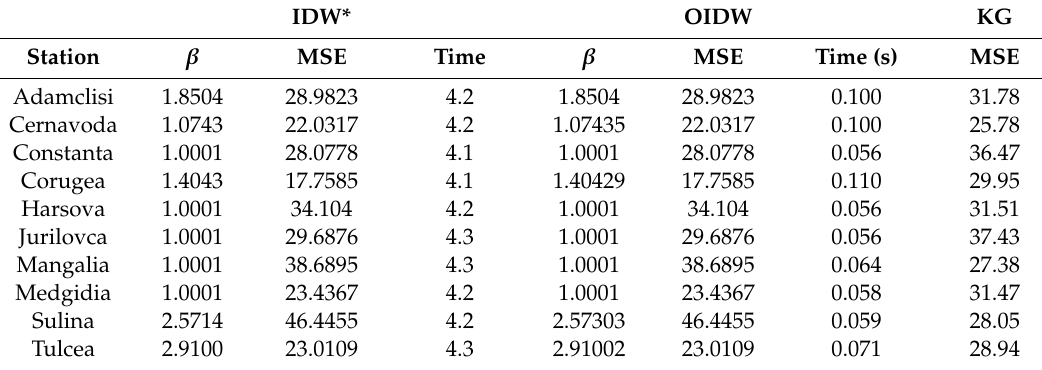
Table 5. Parameter β values obtained in experiments performed using the series recorded at all the meteorological stations in the scenario B2. Comparison with